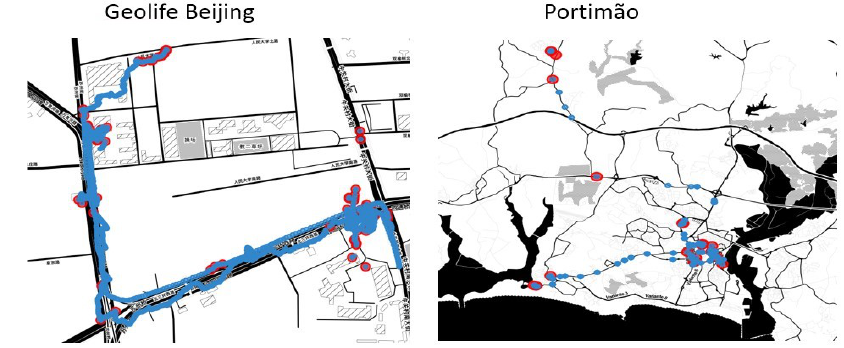
Figure 6. Detection of outliers with LOF in the GEO and PTM